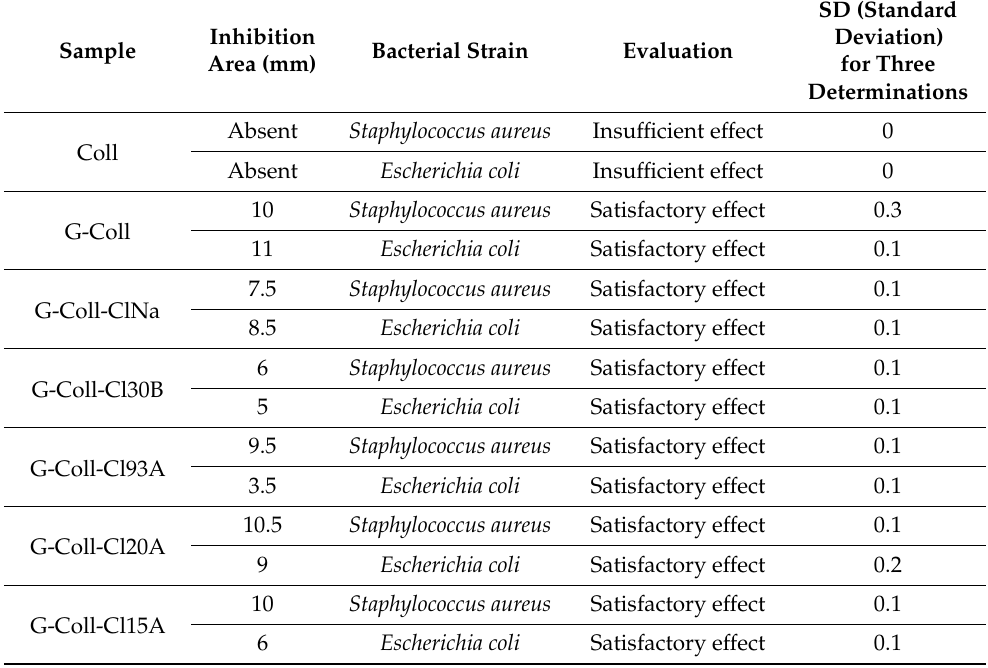
Table 3. Evaluation of the antimicrobial activity of the composite samples loaded with